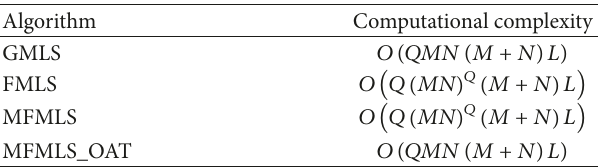
Table 1: Comparison of computational complexity of different algorithms.